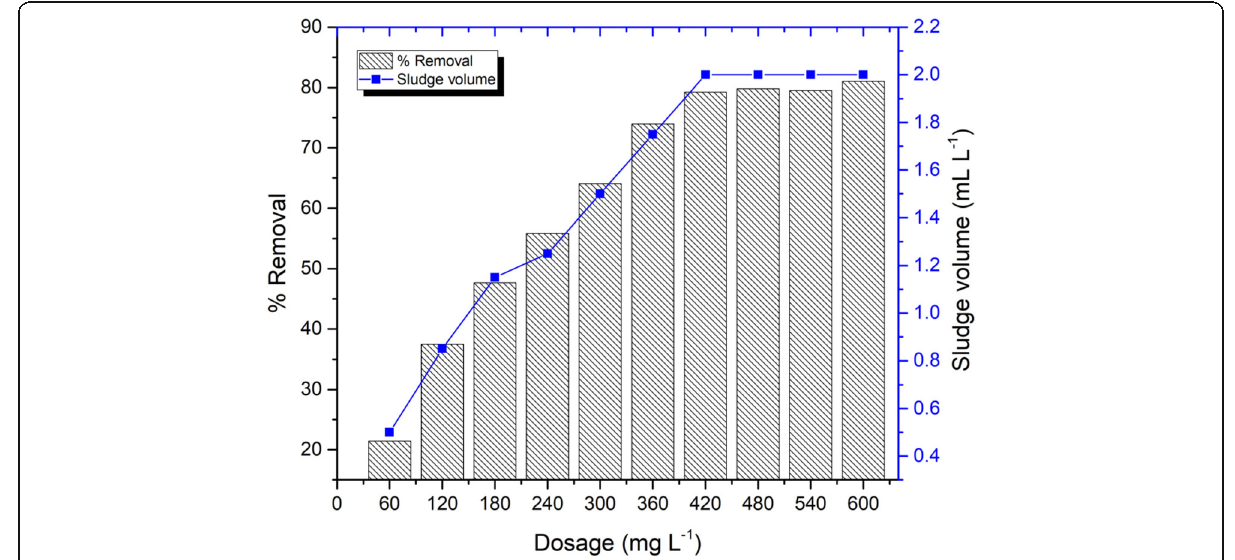
Fig. 4 The effect of magnetic coagulant dosage to the coagulation